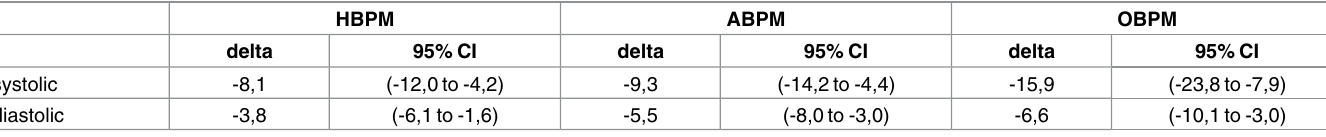
Table 4. Rate of changein bloodpressuremeasured by various